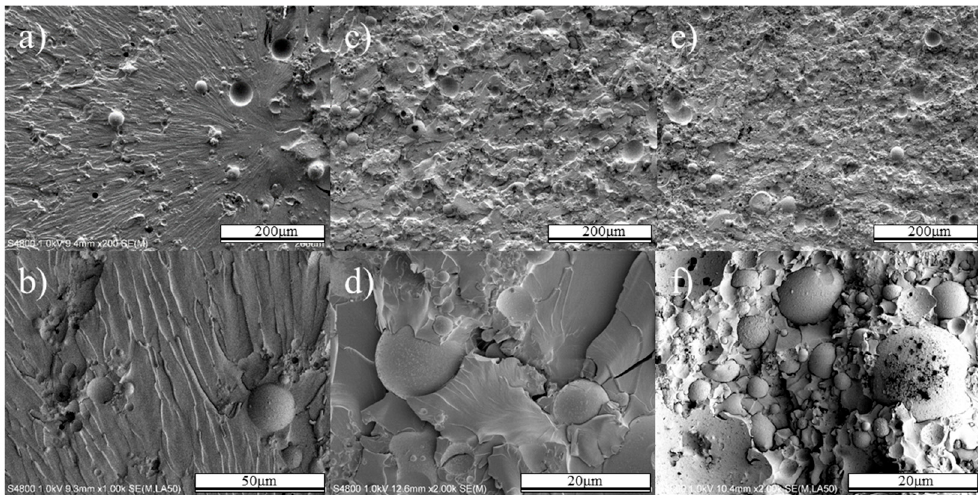
Figure 7. Fracture surface of less than 53 μ m fly ash/epoxy composite in the direction of tensile loading. 10 vol.% fly ash/epoxy composite (( a ) low magnification, ( b ) high magnification), 30 vol.% fly ash/epoxy composite(( c ) low magnification, ( d ) high magnification), 50 vol.% fly ash/epoxy composite (( e ) low magnification, ( f ) high magnification.) .